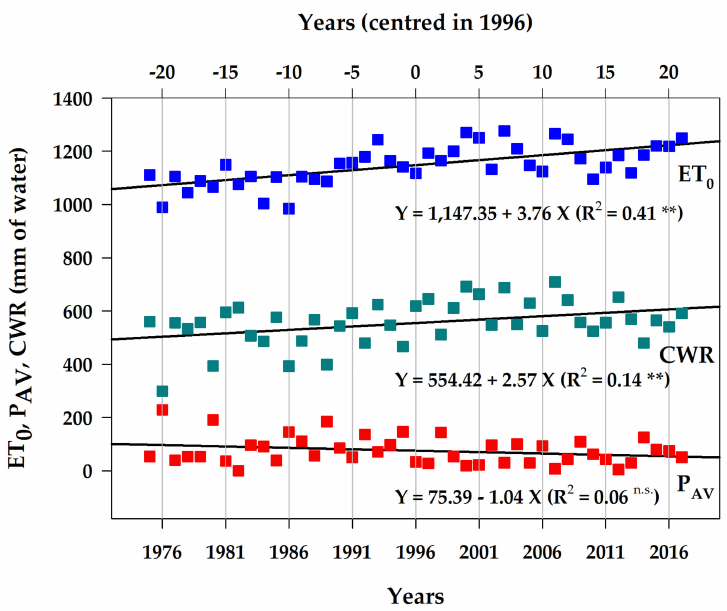
Figure 5. Time trends of reference evapotranspiration (ET 0 ), available precipitation (P AV ), and crop water requirement (CWR) determined over a 43-year period (from 1975 to 2017). Annual data are related to the tomato crop cycle (from 110 ◦ to 230 ◦ days of each